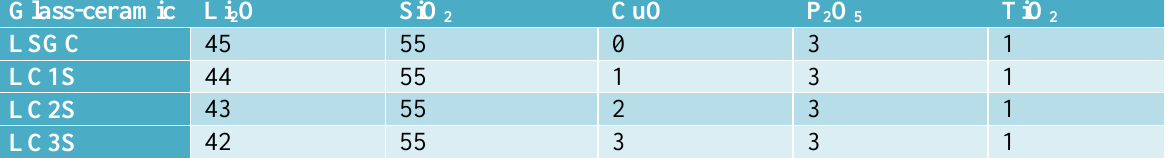
Table 1: The ingredients of prepared glass-ceramics with weight